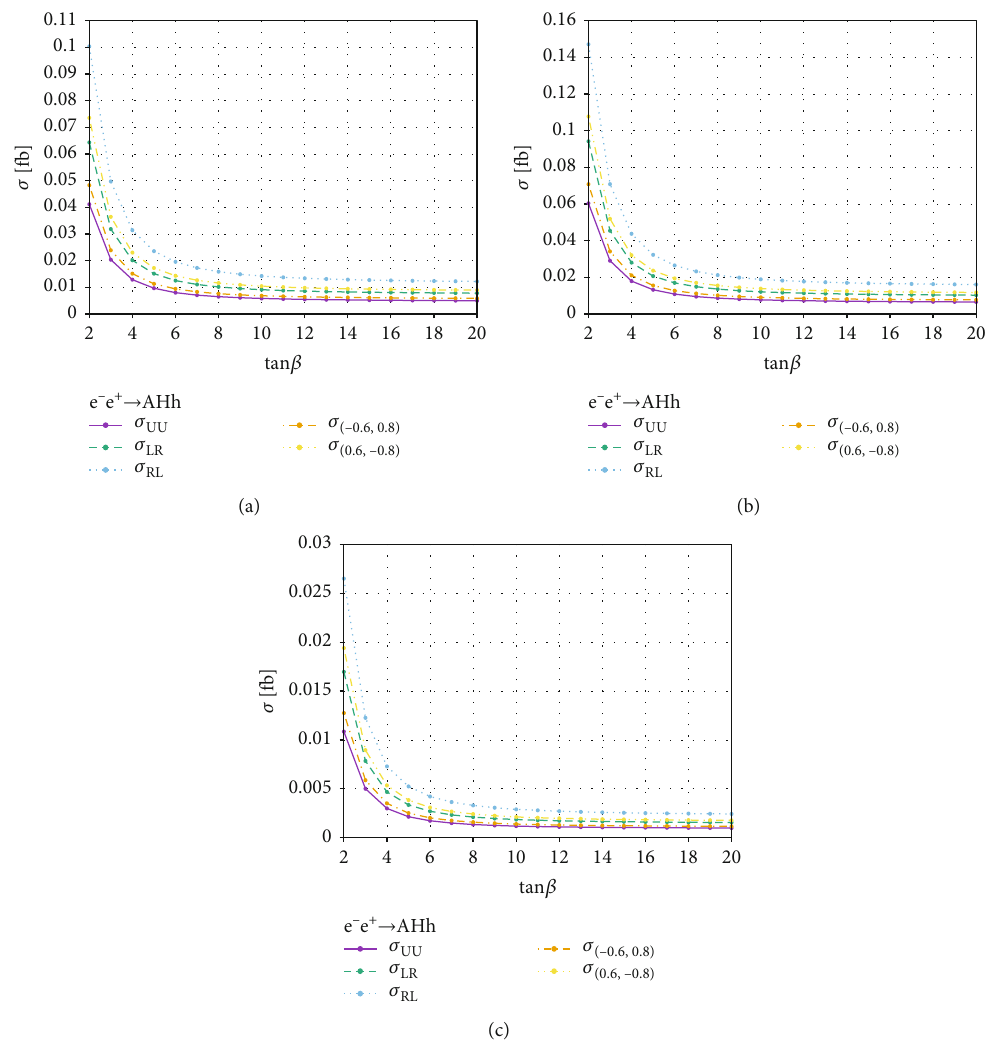
ffiffi p = 1 TeV, and (c) s